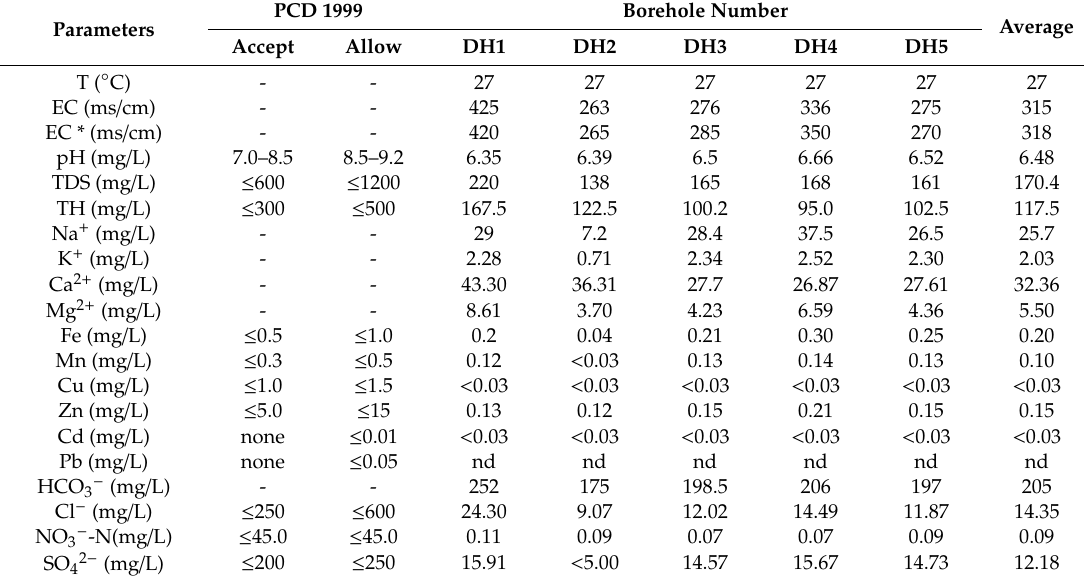
Table 1. Groundwater quality of project